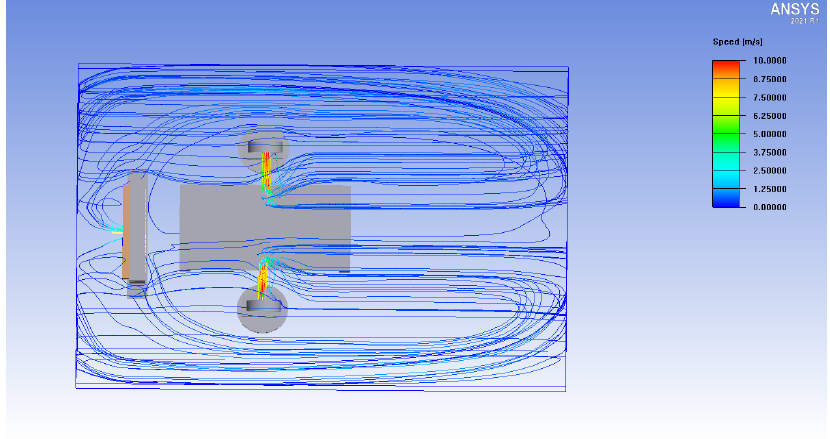
Figure 19. Air purifier simulation top view in the consulting room at a low rotation speed.